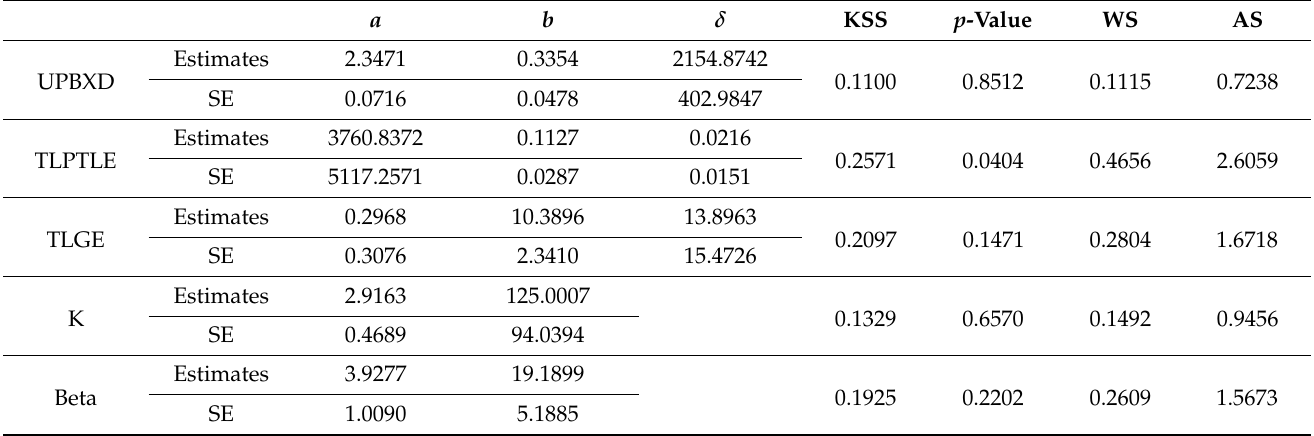
Table 8. Estimates with SE and goodness of fit statistics of ML: The United Kingdom data